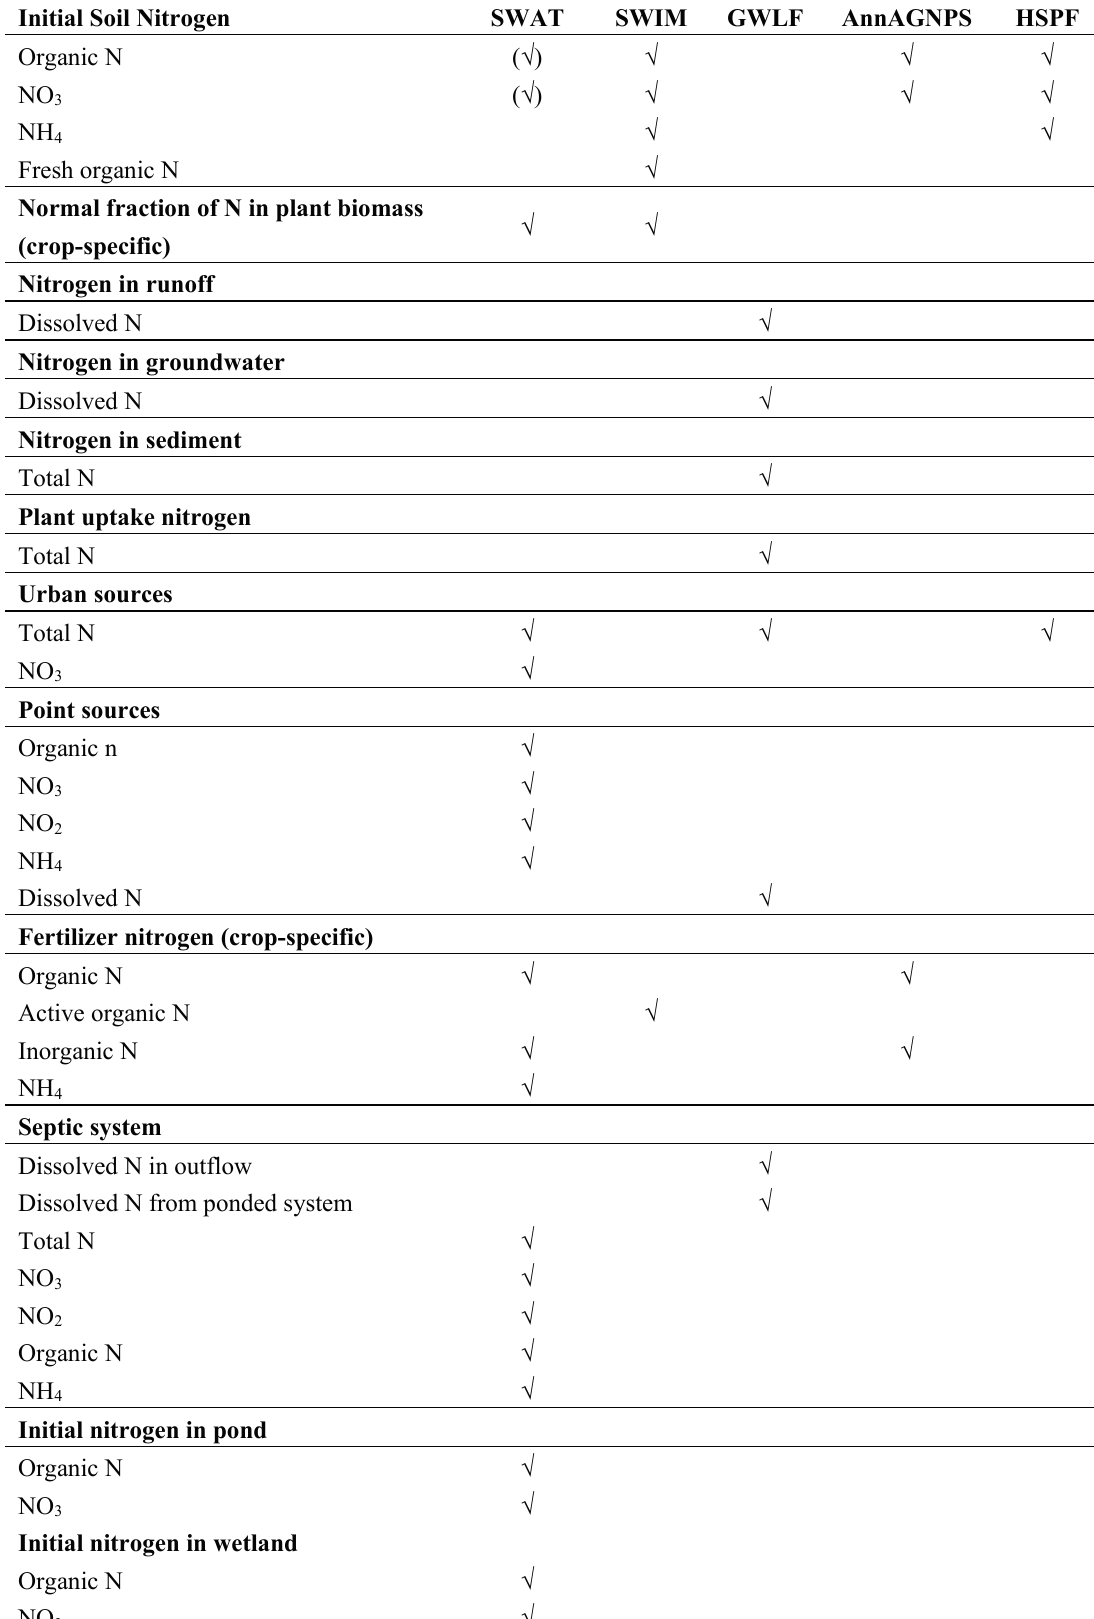
Table 3. Nitrogen input (“( √ )” means this input can be either supplied by measurements, or calculated by the model using